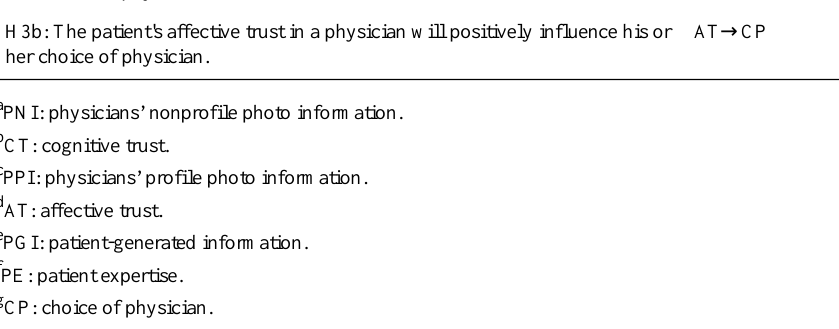
Supported? P value t testPath coefficientPathHypothesis